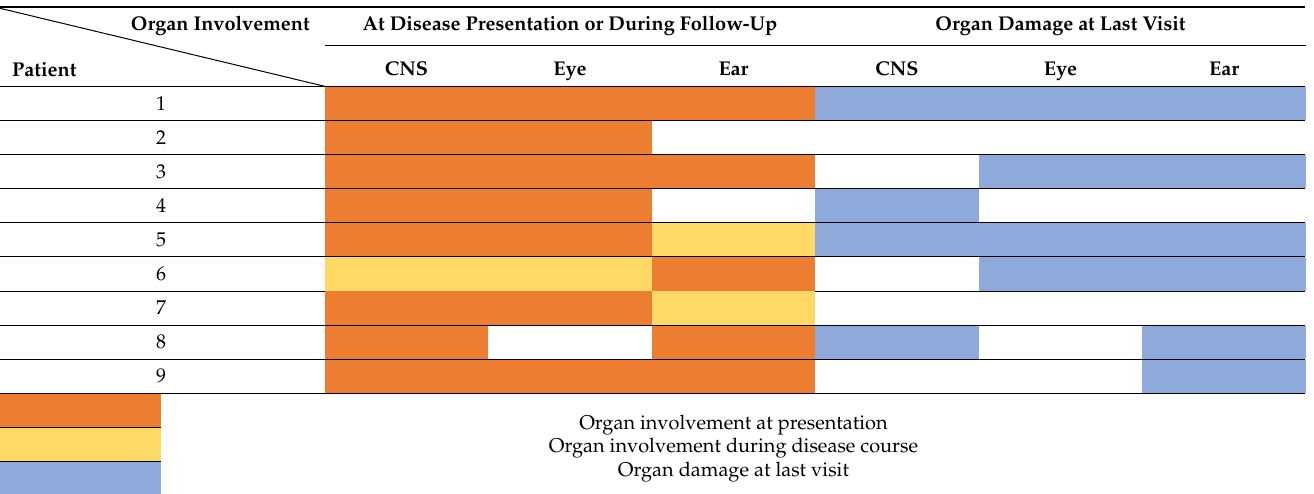
Abbreviations: CNS: central nervous